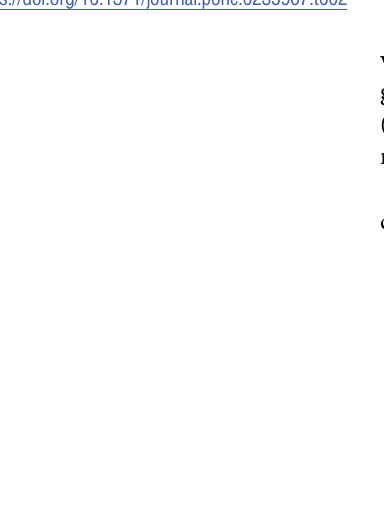
different letters indicate significant differences groups each other, p <